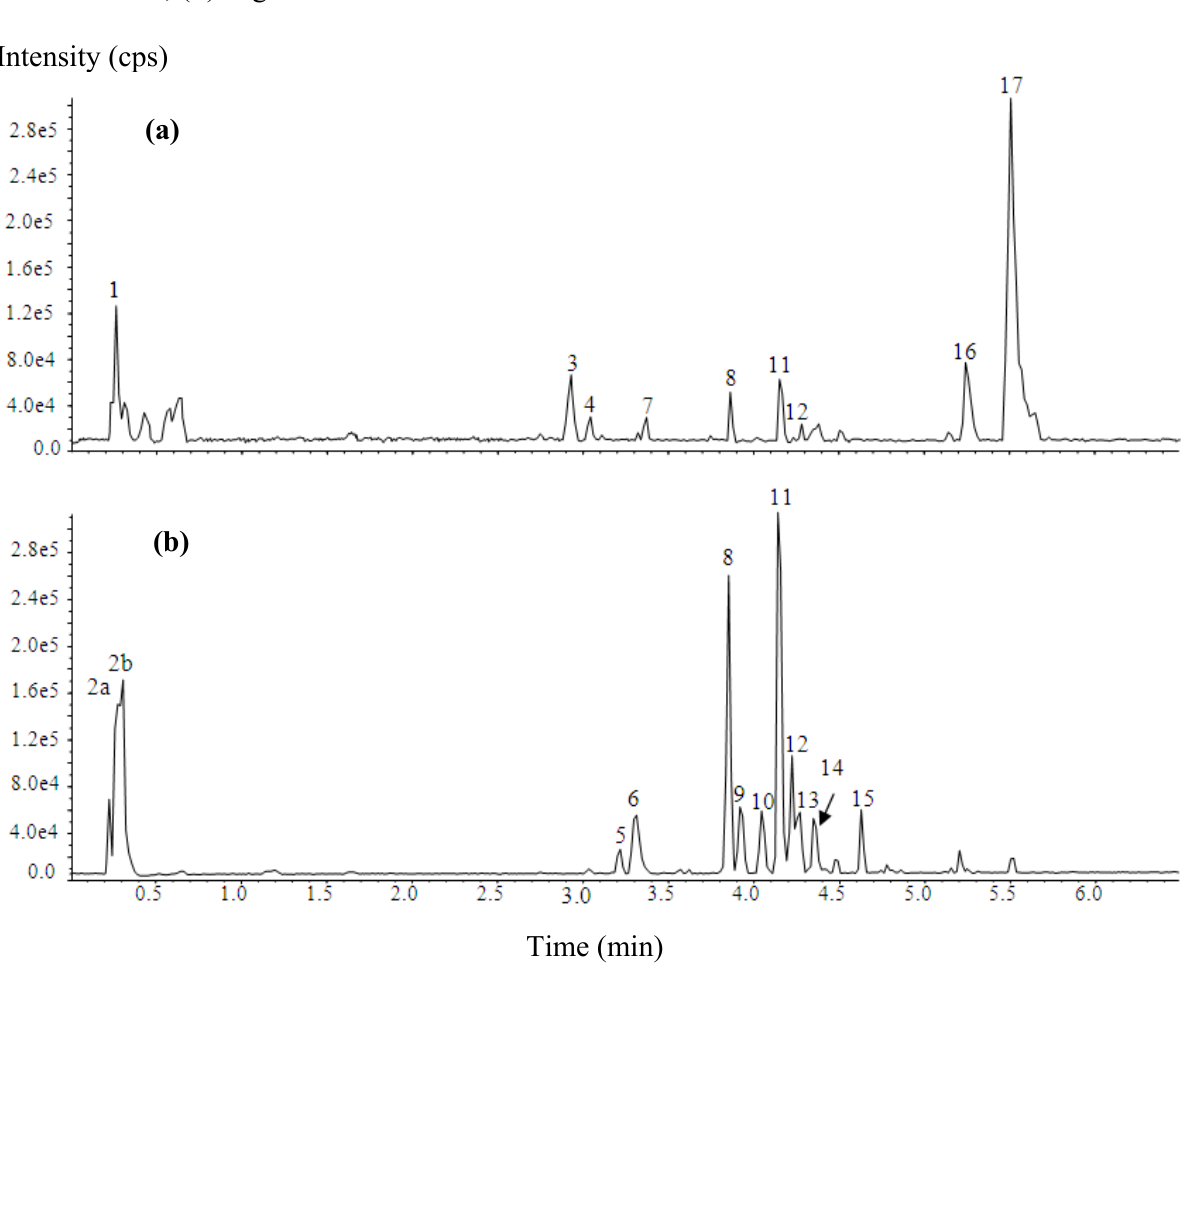
Figure 1. Base peak chromatograms of the studied C. papaya leaf extracts: ( a ) positive ionization; ( b ) negative